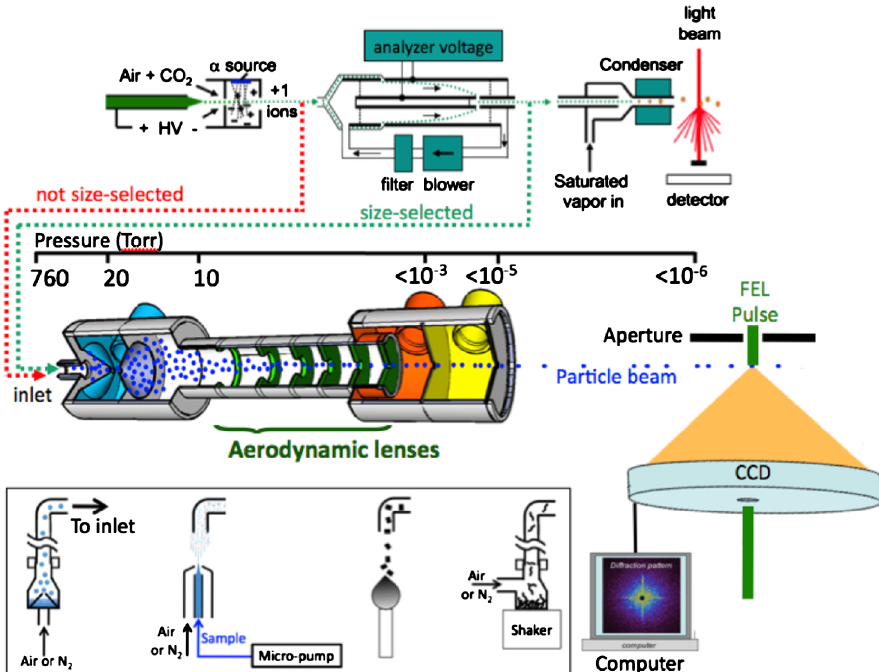
FIG. 1. Conceptual schematic of single-pulse x-ray scattering from single particles in a substrate-free manner. In one variation, electrosprayed spherical nanoparticles are size selected by differential mobility analysis prior to introduction to the differentially pumped aerodynamic lens stack. The particle beam is steered into the FEL and single-pulse diffraction patterns are recorded on a CCD. Alternative aerosol sources tested include nebulizers, atomizers, flames, and dispersion of dry